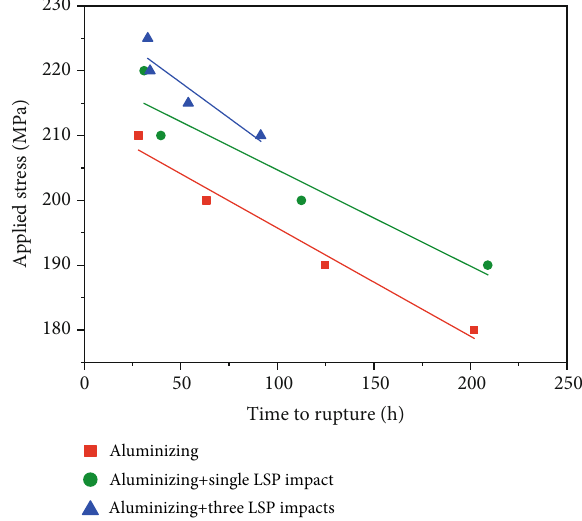
Figure 7: Stress dependence of minimum creep rates for aluminized specimens at di ff erent surface modi fi cation